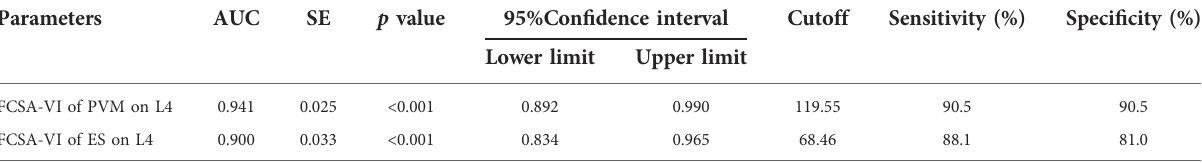
TABLE 5 The results of ROC analysis for FCSA-VI of ES and PVM at L4 level. Parameters